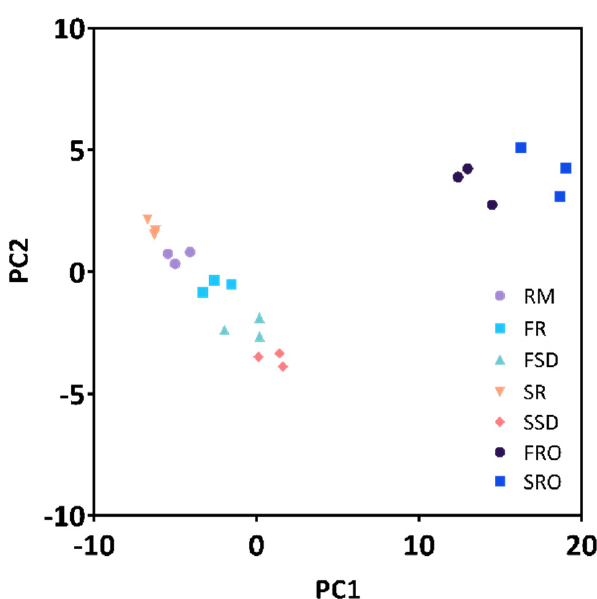
Figure 4. Principal component analysis of proteome of raw camel milk and processed camel milk powders. RM, raw milk; FR, freeze-dried raw milk powder; FSD, spray-dewatering-concentrated/freeze-dried milk powder; SR, spray-dried raw milk powder; SSD, spray-dewatering-concentrated/spray-dried milk powder; FRO, reverse-osmosis-concentrated/freeze-dried milk powder; SRO, reverse-osmosis-concentrated/spray-dried milk powder.